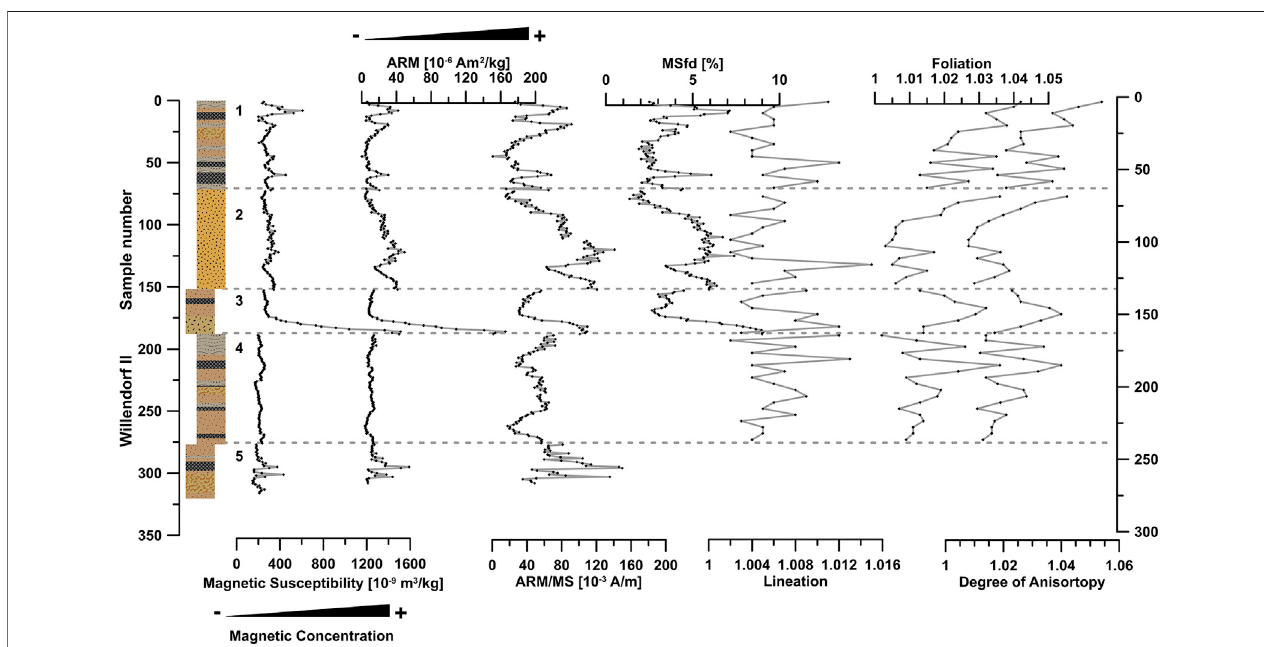
FIGURE 3 | Rock magnetic parameters for the fi ve pro fi les (from Figure 2 ; plotted on top of each other against lithology on the left), and their interpretation regardingmagneticconcentrationandgrainsizeforthemagneticsusceptibility(MS),anhystereticremeanentmagnetisation(ARM)andtheARM/MSratio.Thefrequency dependent magnetic susceptibility ( χ fd %) may be regarded as representing a combination of magnetic concentration and grain size. Note that the ordinate is not representing a continuous stratigraphy.